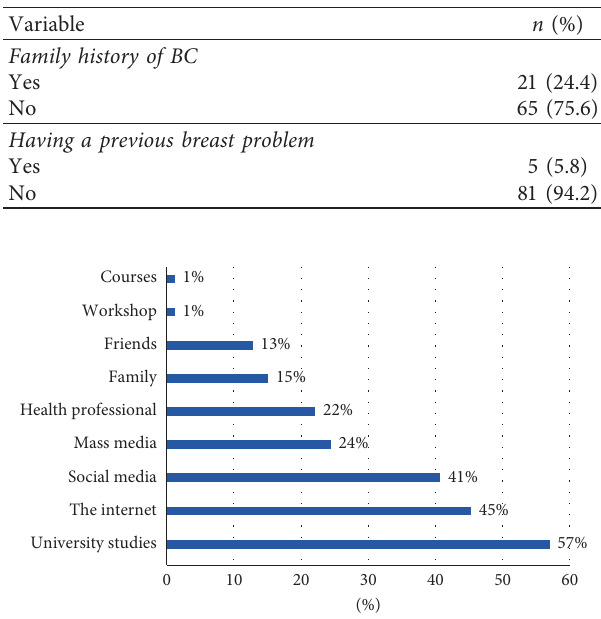
Figure 1: Sources of information about